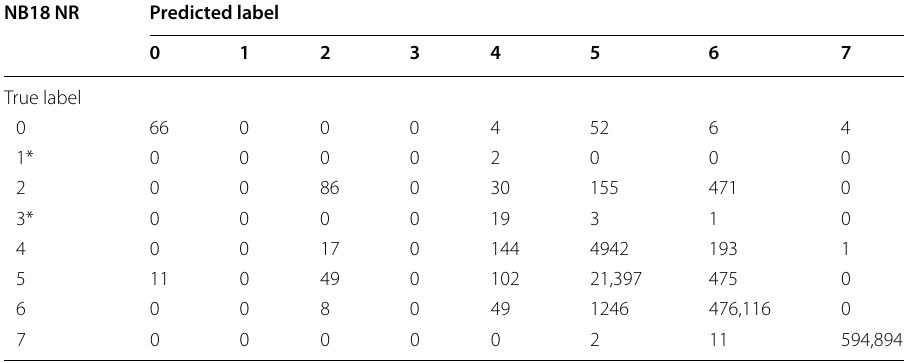
Table 31 Confusion matrix: NB18 NR